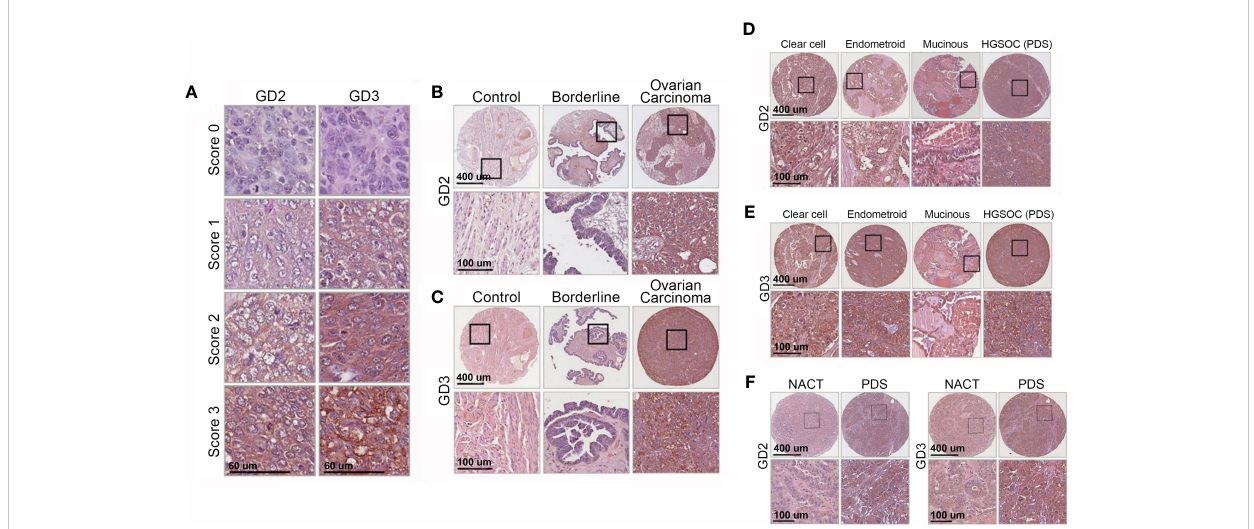
FIGURE 2 Immunohistochemistry shows high GD2 and GD3 in tissues of all OC subtypes. (A) Immunohistochemical detection of GD2 and GD3 in OC biopsies. Images show representative pictures of anti-GD2 and anti-GD3 antibody staining, scored as “ 0 ” (no staining), “ 1 ” (weak staining), “ 2 ” (moderate staining), and “ 3 ” (strong staining). Scores “ 0 ” and “ 1 ” were considered negative, and scores “ 2 ” and “ 3 ” were deemed positive. (B, C) Representative images showing GD2 and GD3 immunohistochemistry in normal, borderline ovarian tumor, and OC tissue biopsies. The bottom panels show a higher magni fi cation of tissue within the black boxes (scale bars indicated). (D, E) Representative images showing GD2 and GD3 immunohistochemistry in clear cell, endometrioid, and mucinous cancer tissue biopsies, and in primary debulking surgery (PDS) cancer tissue biopsies from high-grade serous cancer (HGSOC) patients. The bottom panels show a higher magni fi cation of tissue within the black boxes (scale bars indicated). ( F ) GD2 and GD3 immunohistochemistry in HGSOC patients with PDS or treated with neoadjuvant therapy (NACT) The bottom panels show a higher magni fi cation of tissue within black boxes (scale bars indicated). See Table 1 for statistical comparisons and summary